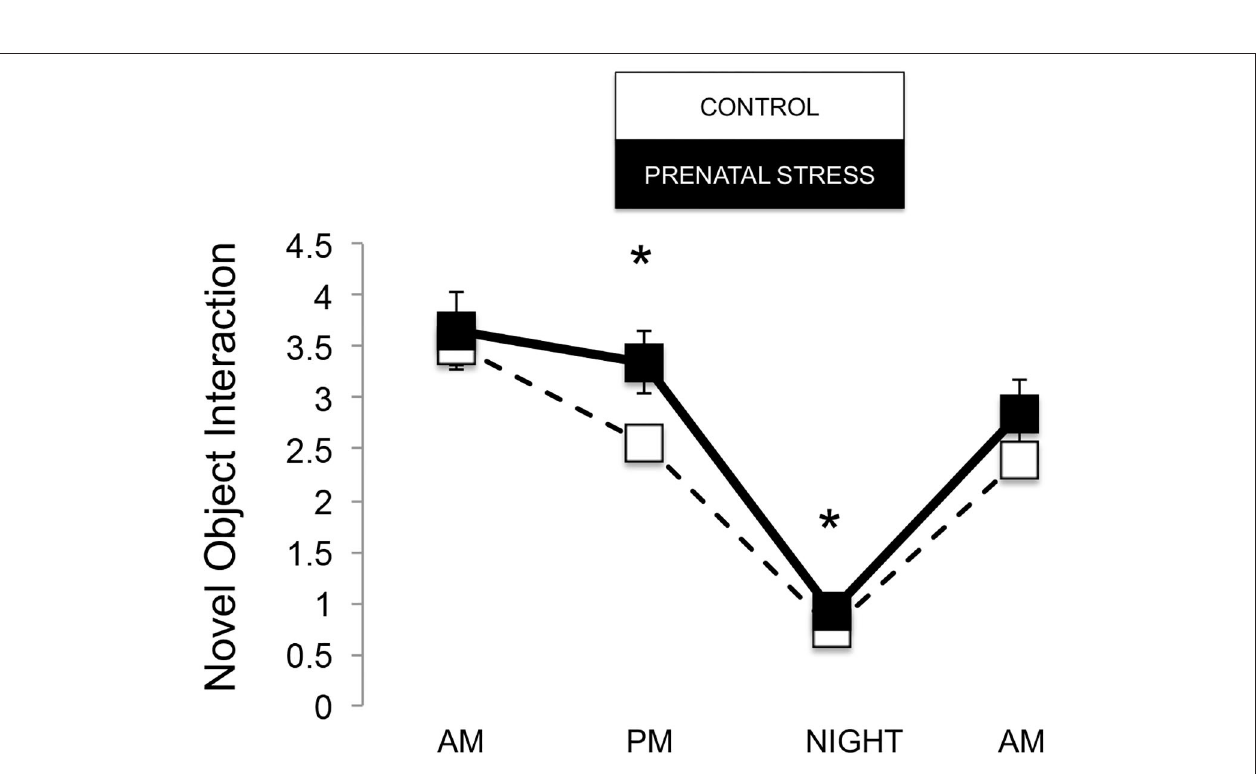
Frontiers in Behavioral Neuroscience |